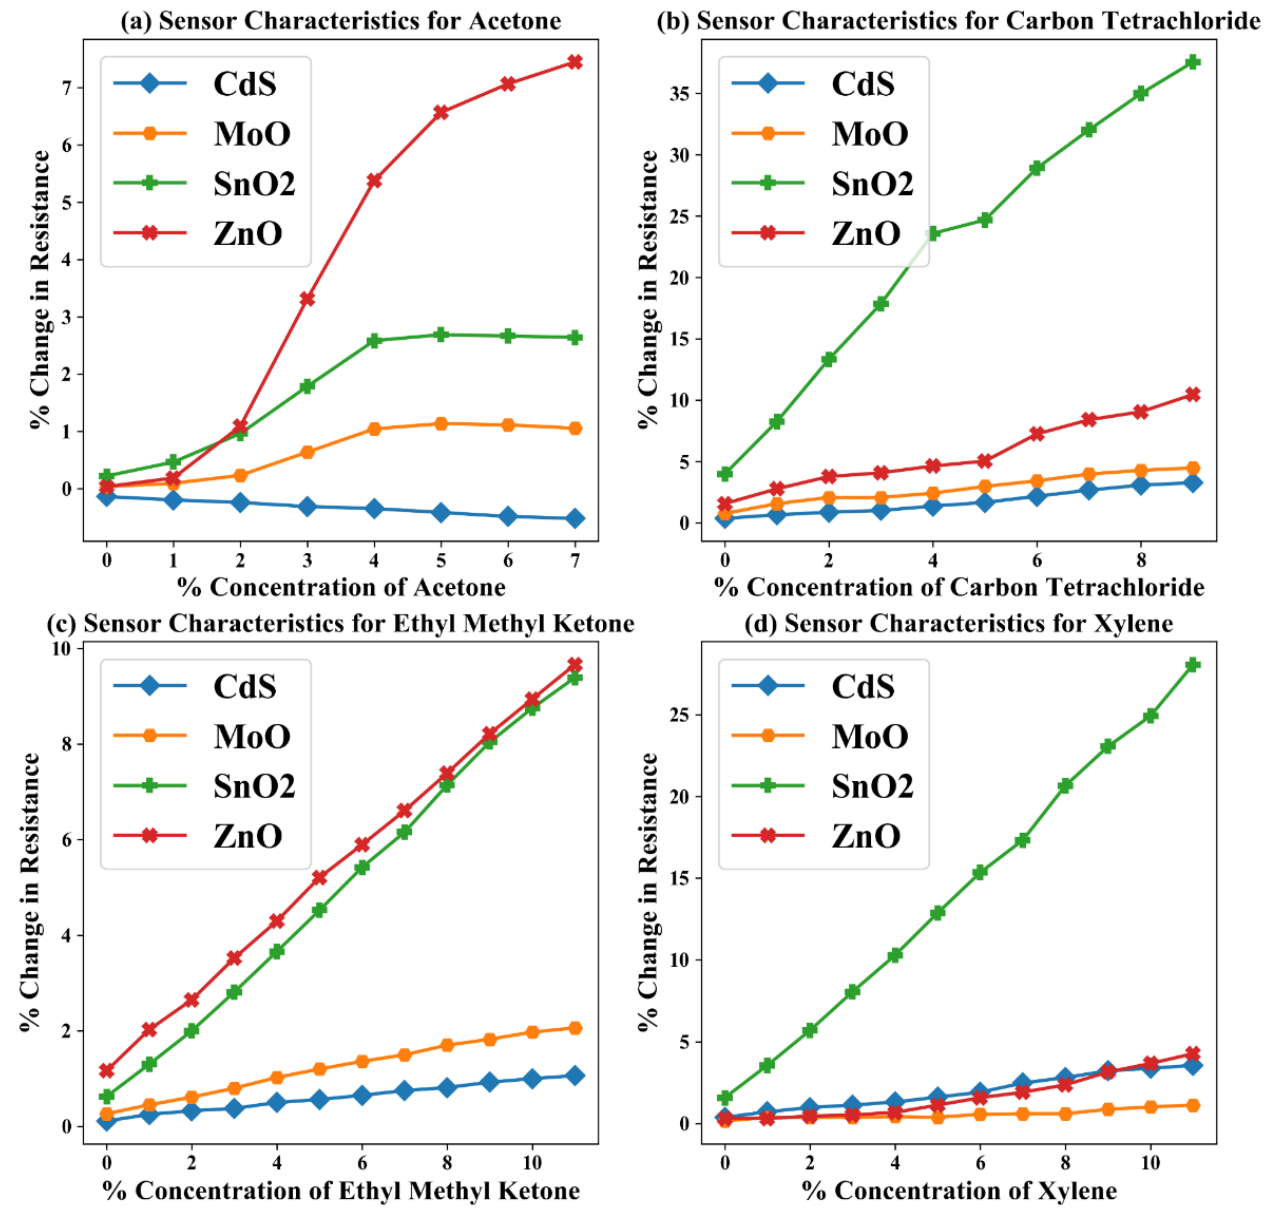
Figure 2. Percent change in resistance of sensor element vs. percent concentration of considered gas characteristics of four elements gas sensor array for four hazardous gases, viz., acetone, carbon tetrachloride, ethyl methyl ketone, and xylene [27].